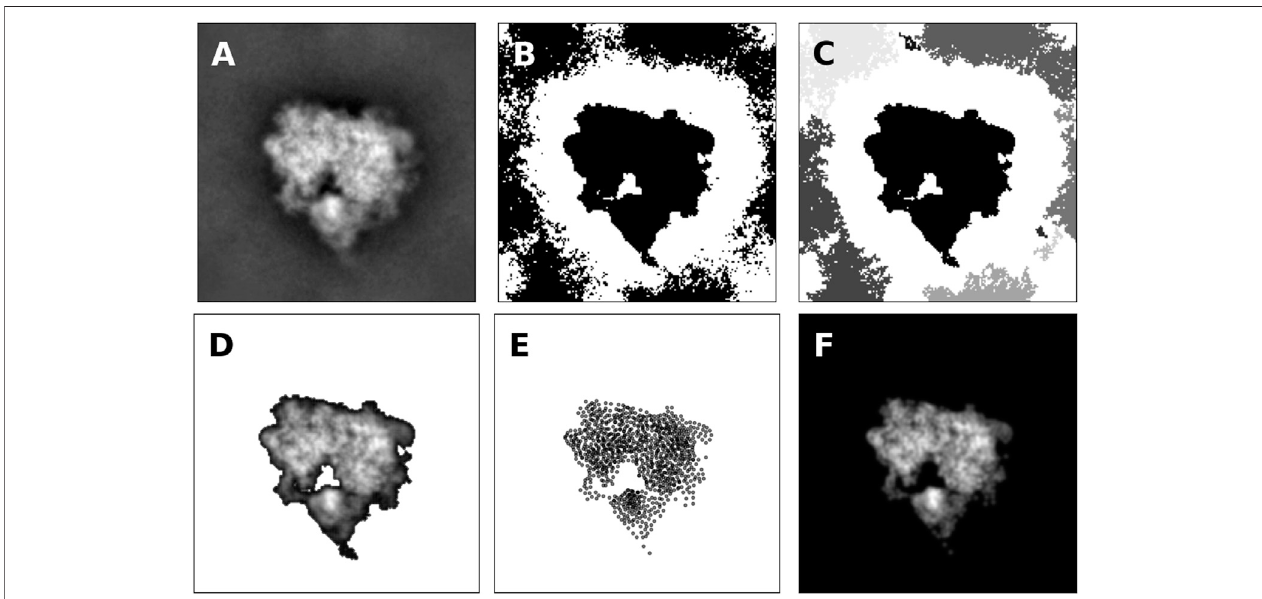
FIGURE 4 | Representation of projection images by 2D point clouds (A) Class average of the 80S ribosome (B) Mask obtained by thresholding image intensities greaterthanthemedianintensity.Blackpixelsarepartofthemask (C) Clusteringofpixelsthatarepartofthemask.Pixelsthatformaconnectedcomponentaregrouped togetherandshownindifferentgrayscalecolors (D) Pixelsthatformthemostcentralconnectedcomponentswithshiftedimageintensities (E) 2Dpointcloudcomposed of 1,000 particles obtained by running the Expectation Maximizationalgorithm (F) Model image according to Eq. 10 . The cross-correlation coef fi cient between the model and the original image is 95.8%. If only pixels are considered that are part of the mask indicating the central connected component, the cross-correlation coef fi cient increases to